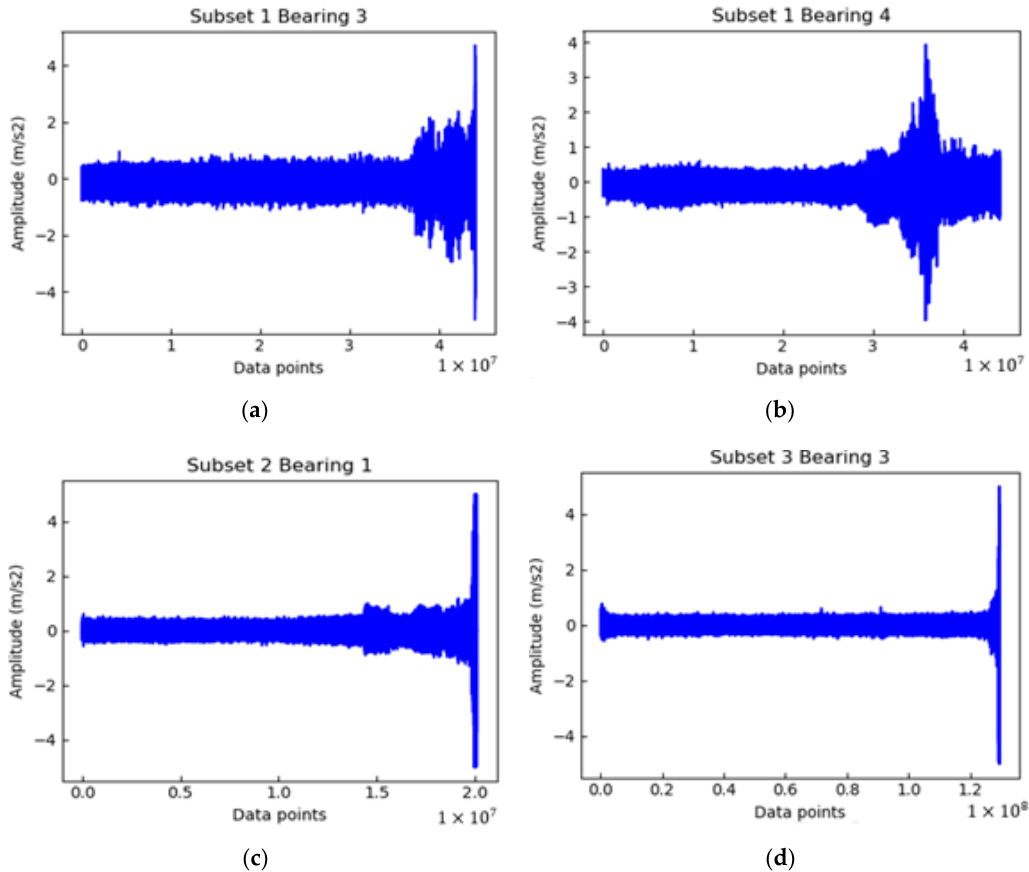
Figure 5. Intelligent maintenance systems (IMS) test rig [45].